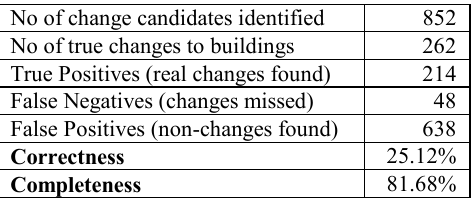
Table 2. Statistics of the results of the rural production trial. Using contractor imagery of a slightly lower spatial resolution than that normally captured by our own camera (25 cm